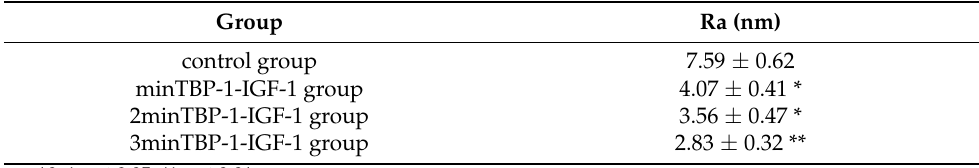
Table 1. Ra values of surface roughness of the four experimental groups.